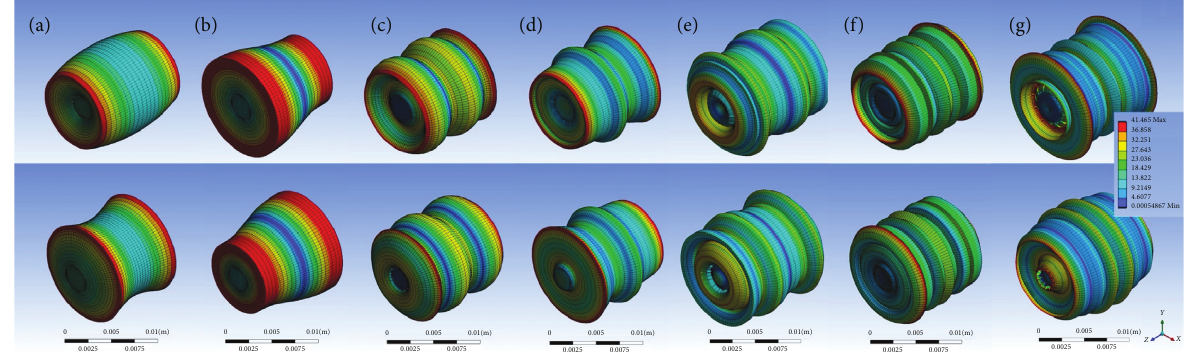
Figure 9: Qualitative opposite extreme deformation (top and bottom) of different vibration modes obtained by modal analysis of sample #1 SGL R6650 that coincide with dominant frequency contributions were measured during the experiment. The vibration modes have frequencies of 153.4 (a), 186.4 (b), 319.5 (c), 477.3 (d), 804.0 (e), 899.7 (f), and 978.4kHz (g). Color coding qualitatively represents the normalized magnitude of deformation. Scale bars correspond to 10 mm.